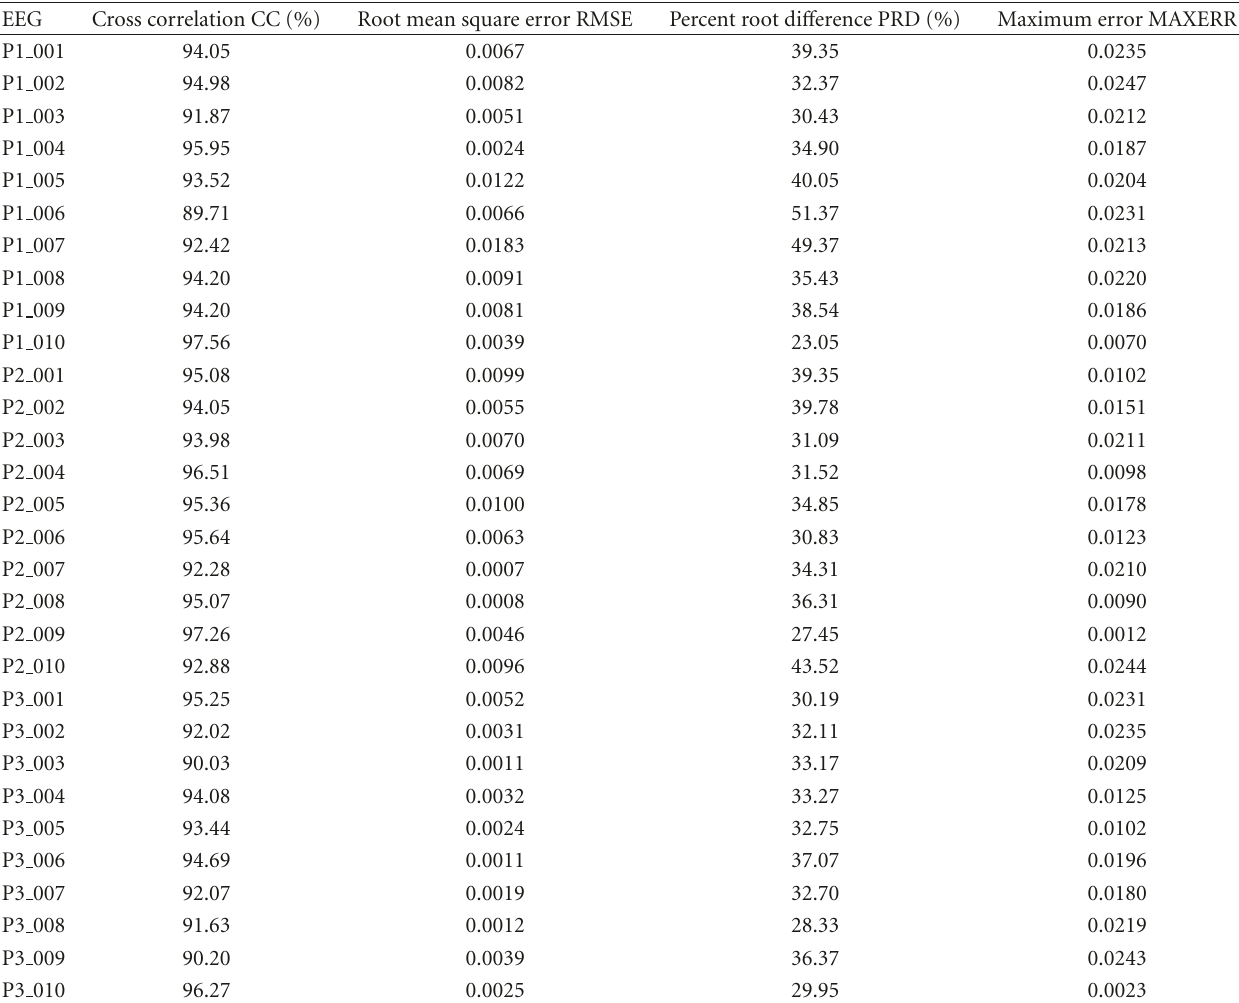
Table 3: Performance of our method: CC , RMSE , PRD , and MAXERR .